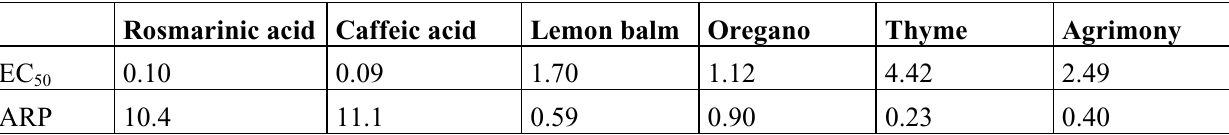
Table 3 . Antiradical activity of the plant extracts determined spectrophotometrically with the DPPH , in g antioxidant/g DPPH) and the antiradical power (ARP = radical. The efficient concentration (EC 50 1/EC 50